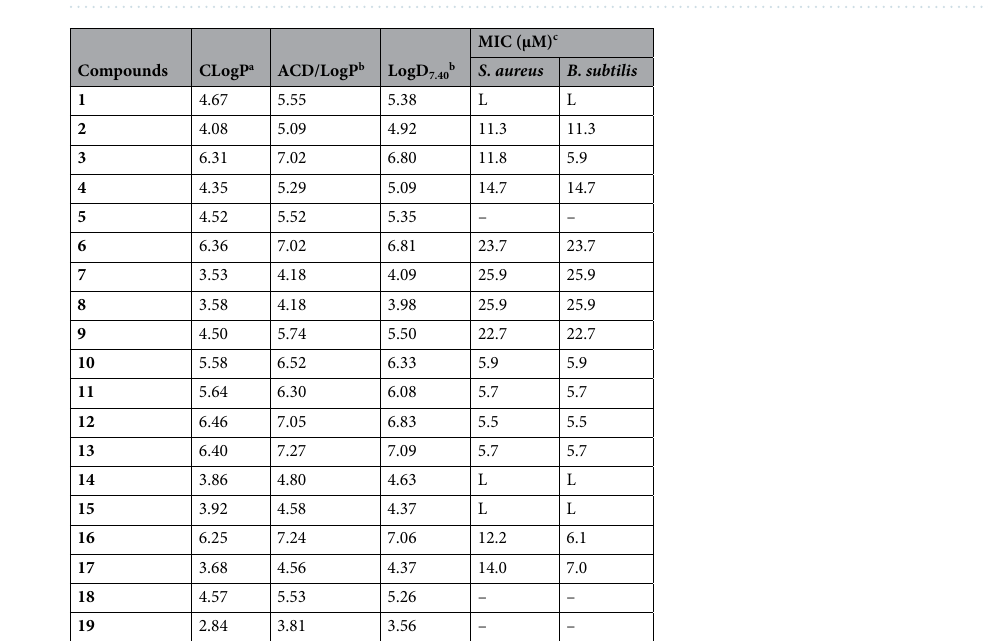
Figure 6. Chemical structures of compounds 55 to 66 15 .